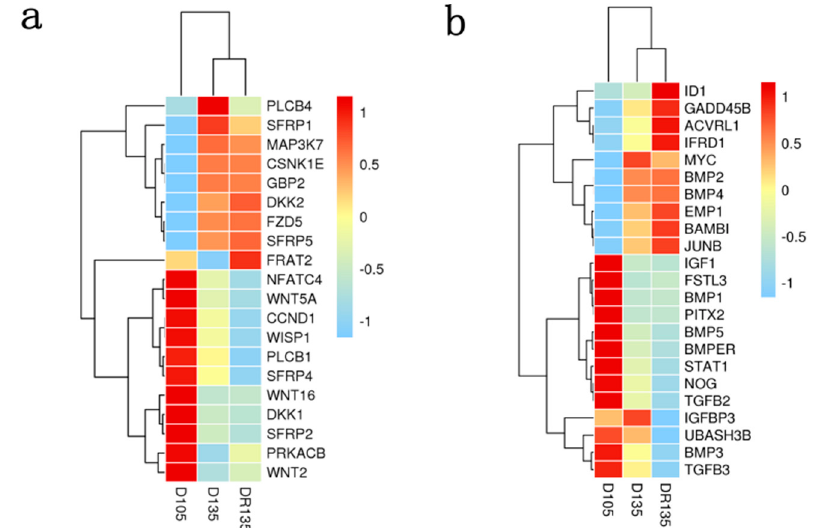
Figure 6. Heat map of the hierarchical clustering of DEGs. ( a ) Clustering heat map of Wnt signal pathway correlated genes. ( b ) Clustering heat map of TGF- β /BMP signaling pathway genes. Each row represents the DEGs, and each column represents samples at a time point. Heat map uses FPKM value and then standardizes. Blue and red gradients indicate a decrease and increase in transcript abundance, respectively. The line on the left represents gene cluster, and the line on the top represents sample cluster.